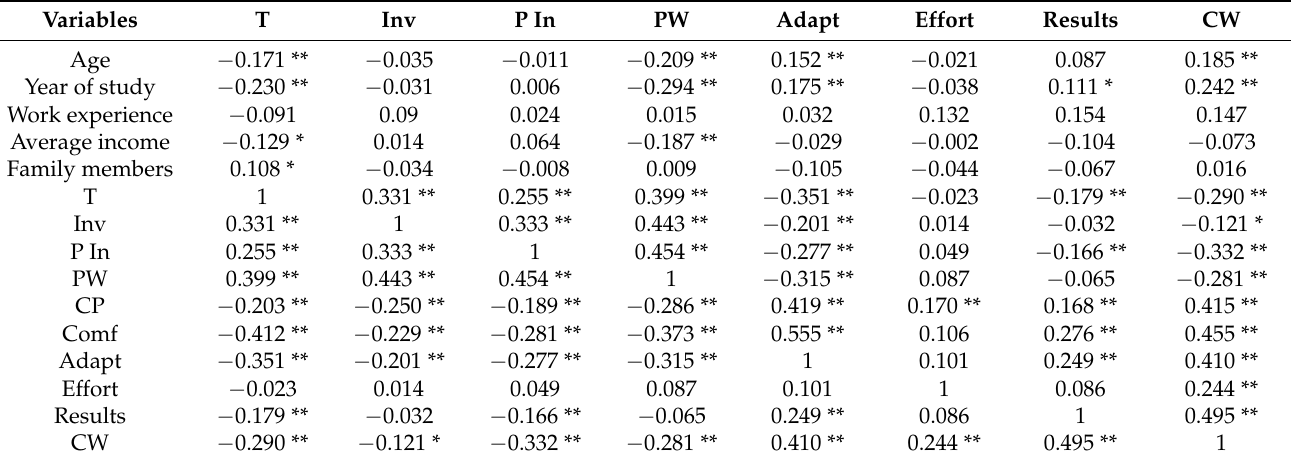
Table 9. Correlations between various variables associated with the group of